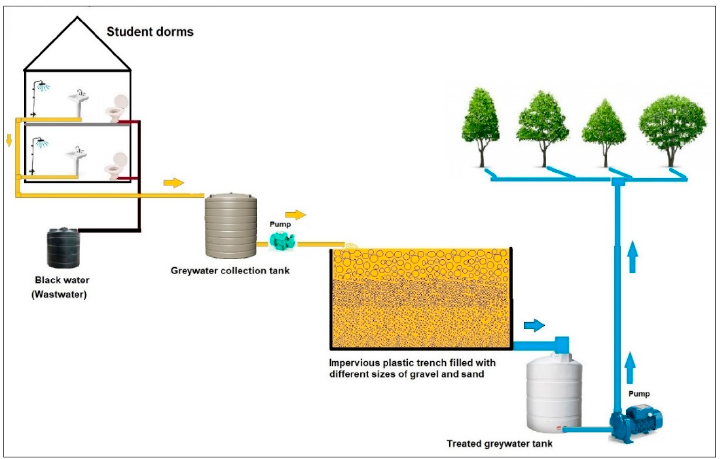
Figure 1. Schematic diagram for the greywater treatment